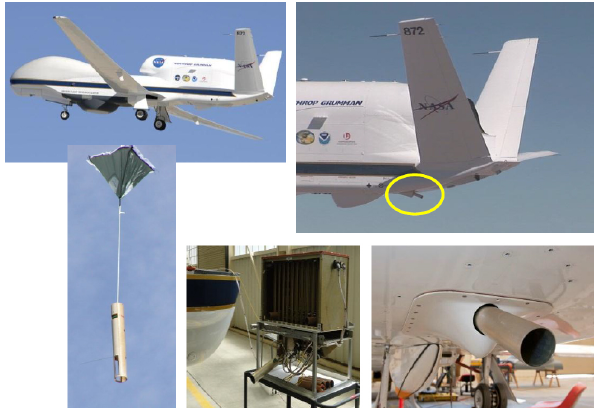
Figure 1. (Clockwise from top left) Global Hawk; close-up of Global Hawk with dropsonde eject tube, circled in yellow (photo courtesy of NASA); close-up of dropsonde launch tube (photo cour- tesy of NASA); dropsonde dispenser and launch assembly; drop- sonde with